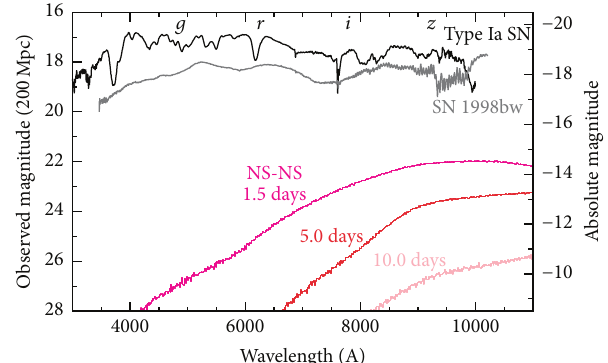
Figure 3: Expected observed spectra of the NS-NS merger model APR4-1215 ( 𝑀 ej = 0.01𝑀 ⊙ ) compared with the spectra of normal Type Ia SN 2005cf [60–62] and broad-line Type Ic SN 1998bw [63, 64]. The spectra are shown in AB magnitudes ( 𝑓 ] ) at 200 Mpc distance. The corresponding absolute magnitudes are indicated in the right